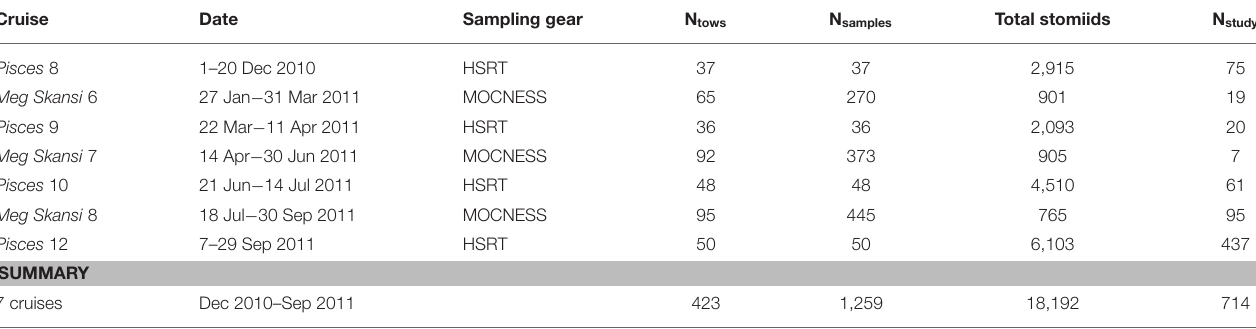
TABLE 1 | Cruise details from the 2010 to 2011 expeditions in the Gulf of Mexico and the total number of stomiid specimens from each cruise used in this study (N study